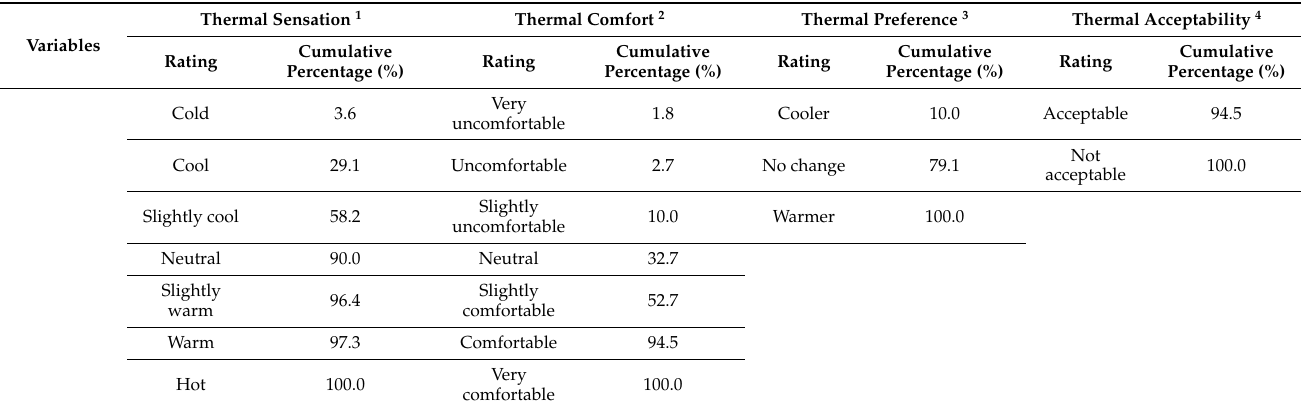
Table 3. Rating and cumulative percentage of thermal sensation, thermal acceptability, comfort, and preference in the case study buildings * (N = 110).